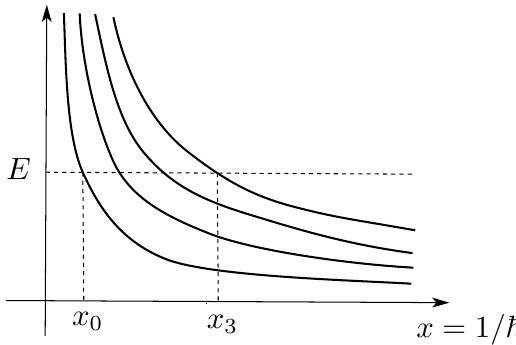
Figure 2 . The spectrum of a quantum system can be regarded as a discrete series of energies for a (cid:12)xed value of ~ , or conversely, as a discrete series of values of the inverse Planck constants x = ~ (cid:0) 1 for a (cid:12)xed value of the energy E . In this (cid:12)gure we show the very (cid:12)rst energy levels E n , as functions of x , and the sequence of x n corresponding to the energy E